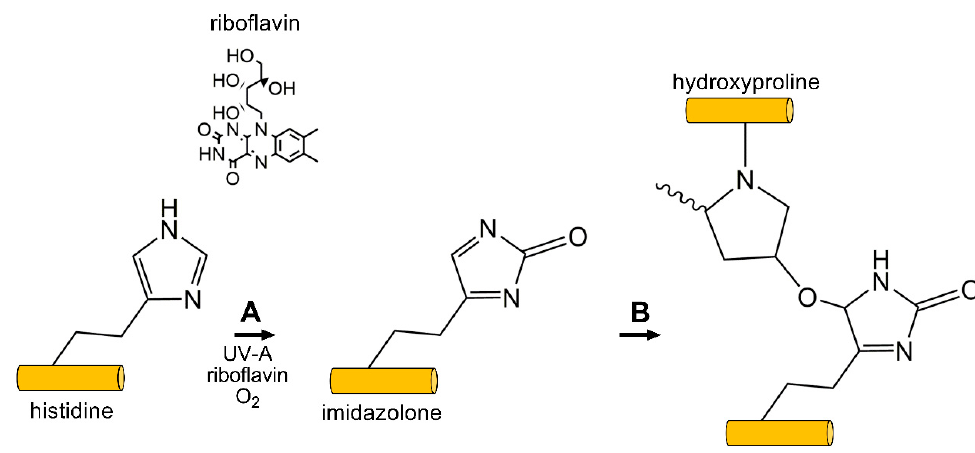
Figure 5. Photooxidative CXL commonly uses the photoxidizing agent riboflavin, and exposure to short wavelength UV light (360 nm) to generate free-radicals on ECM proteins, e.g., collagen and proteoglycans. ( A ) Singlet-oxygen reacts with histidine (shown) or other reactive carbonyl groups forming an imidazolone intermediate. ( B ) A reactive nucleophile, such as the hydroxyl group on hydroxyproline (shown), threonine, or tyrosine, reacts with the imidazolone intermediate generating inter- and intramolecular crosslinks between and within collagen and surrounding proteoglycans.